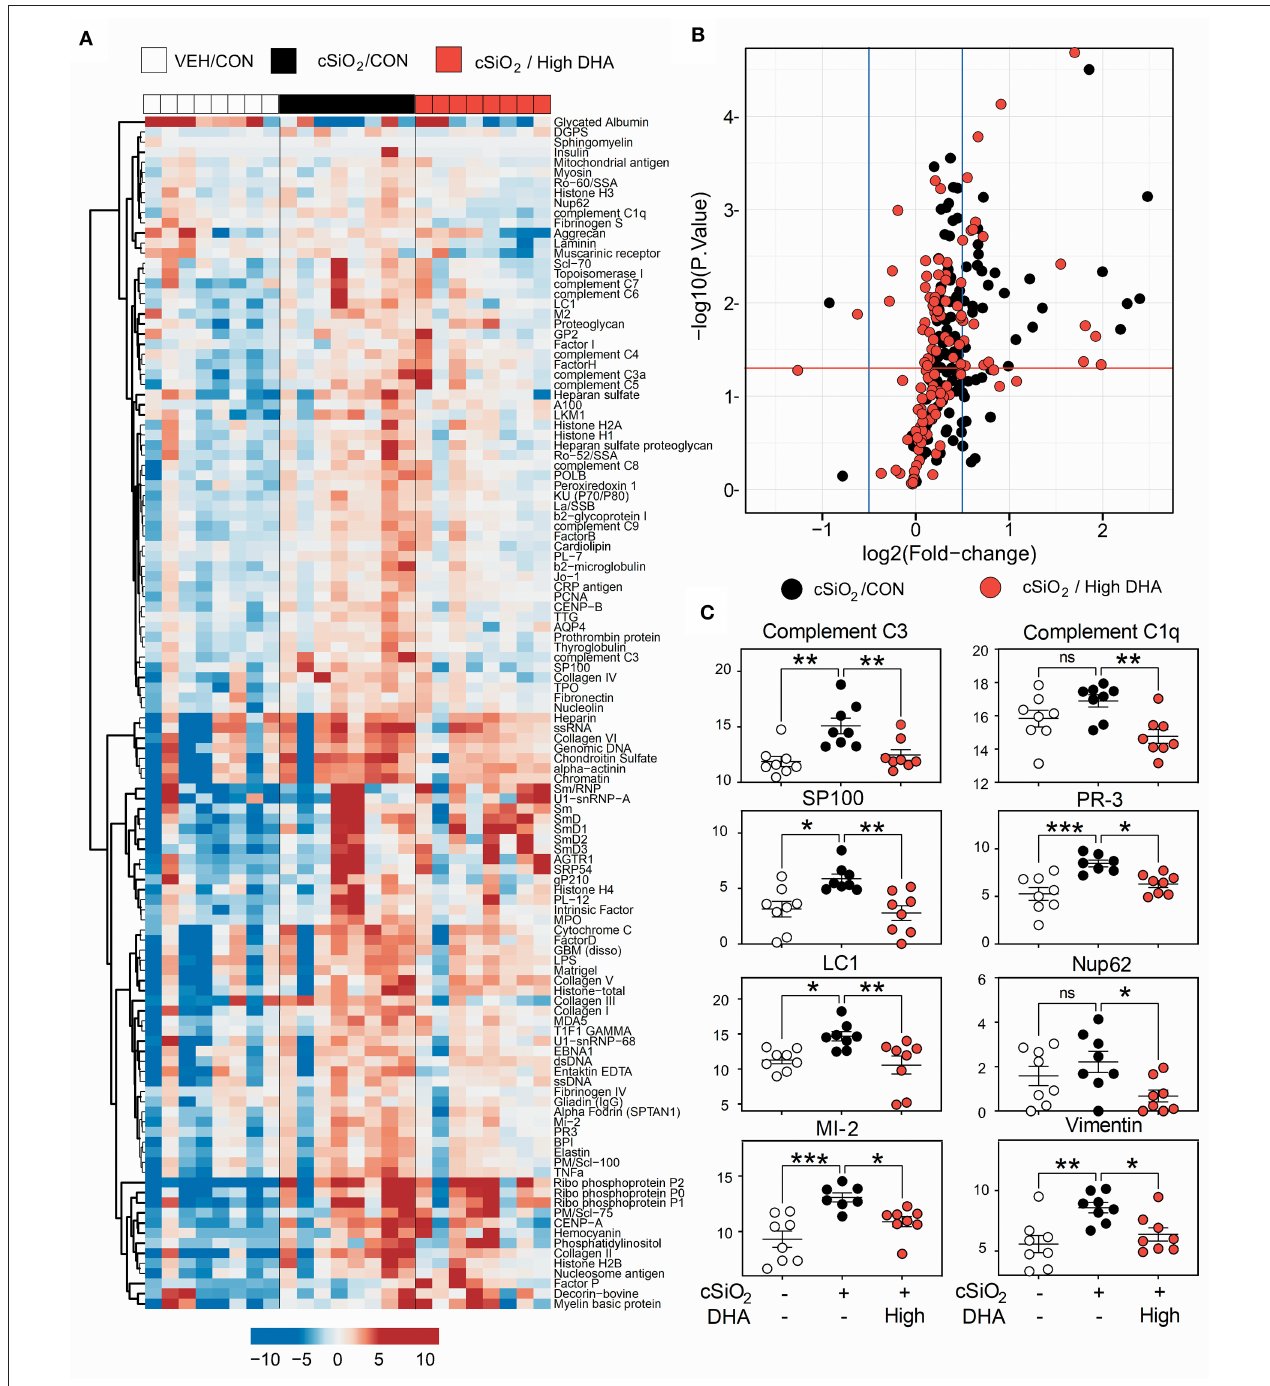
FIGURE 9 | High DHA supplementation inhibits a broad spectrum of IgG autoantibodies induced by cSiO 2 . (A) Heat maps with unsupervised clustering (Euclidian distance method) of 122 AAbs depict Ab-score values for IgG expression in BALF. White, black, and red in the top key indicates the Veh/CON, cSiO 2 /CON, and cSiO 2 /high DHA experimental groups, respectively. Scale bar values reflect the range of variance-stabilized Ab scores, which were centered across rows. (B) Volcano plots depicting cSiO 2 -induced IgG AAb responses in plasma at 13 week post final exposure in lung of cSiO 2 -treated NZBWF1 mice. The individual AAg within each treatment group are plotted as log 2 (fold change) vs. -log 10 ( p -value). Black dots indicate cSiO 2 /CON relative to Veh/CON treated mice; red dots indicate cSiO 2 /high DHA relative to Veh/Con. The vertical blue lines represent the cut-off levels log 2 fold change < − 0.5 or > 0.5. The horizontal red line represents the cut-off levels p -values ≥ 0.05 (log10 P ≥ 1.2). (C) DHA intake suppressed cSiO 2 -induced IgG AAb responses against selected AAgs. Data presented as mean ± SEM. Statistical comparisons were performed as described in the Methods section. *** p ≤ 0.001, ** p ≤ 0.01, * p ≤ 0.05, ns = not significant.